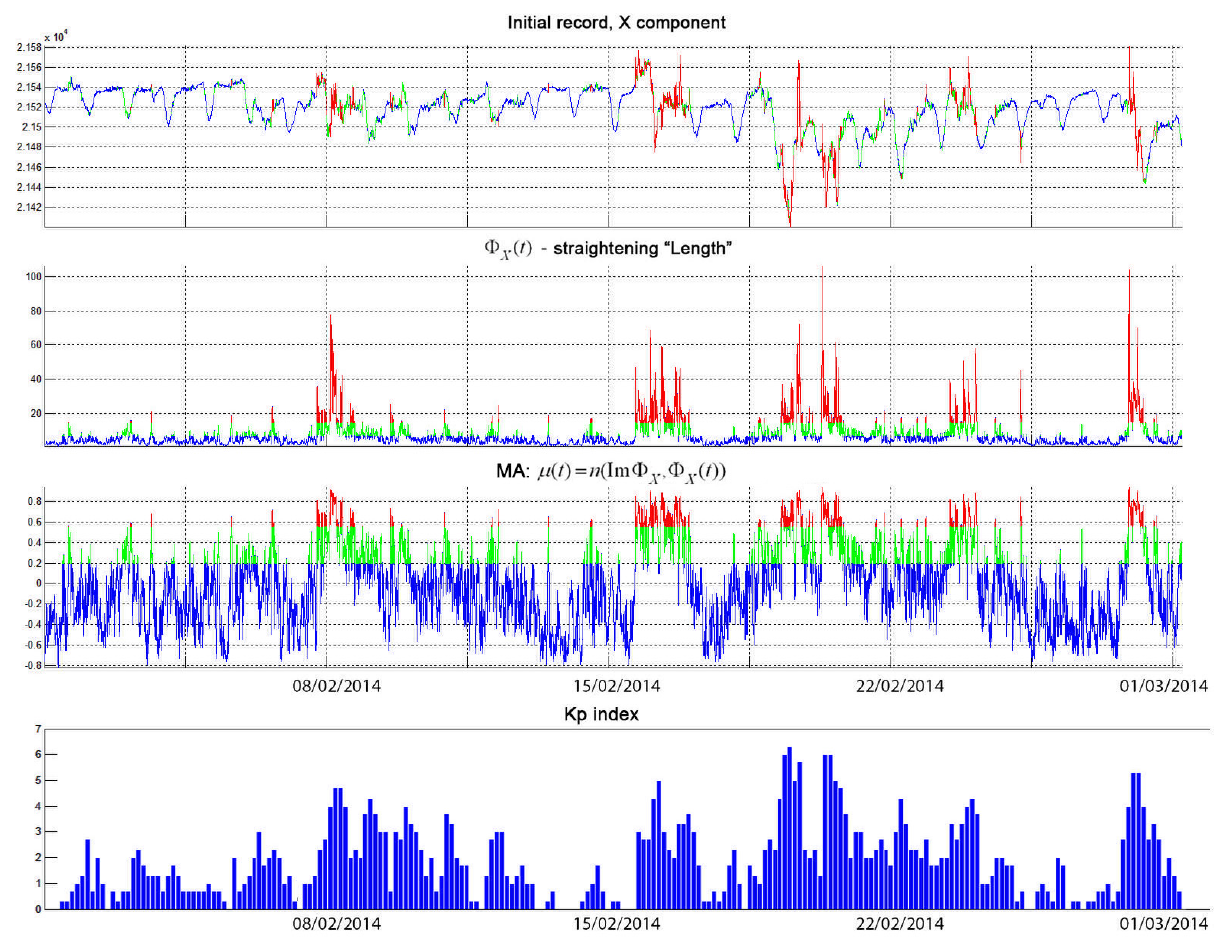
of the record (2-nd plot), MA µ ( t ) ∈ [ − 1, X